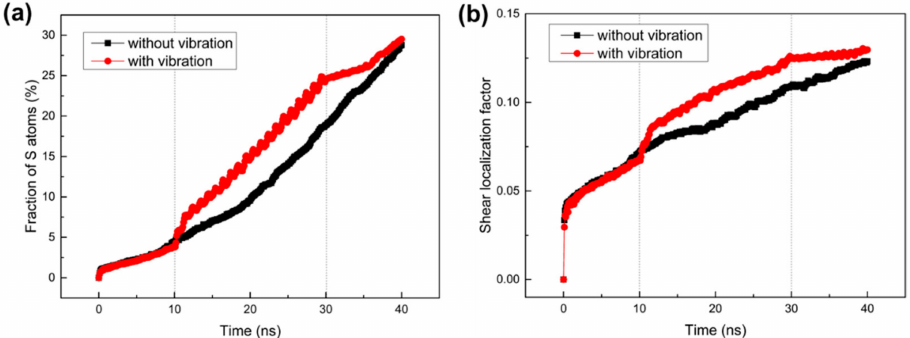
Figure 4. The evolution of ( a ) the fraction of S atoms and ( b ) the shear localization factor during tension.